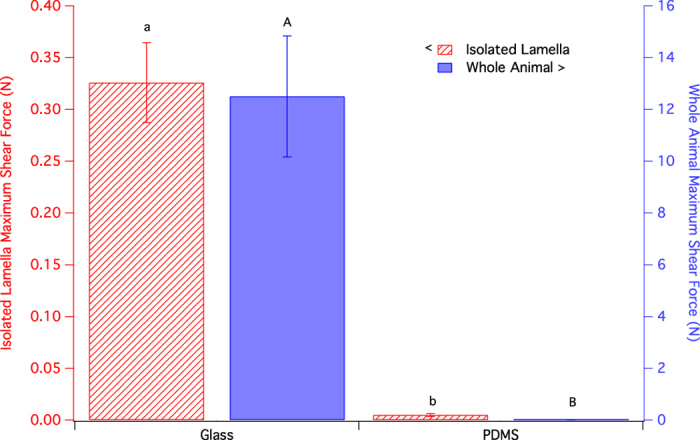
Average maximum shear force of adhesion for whole animal and isolated lamella on glass and 1000 μm PDMS substrates.Values are means ± standard error, n = 7 for both data sets. Results of student’s t-test are labeled in lower case for the isolated lamella experiments, and in upper case for the whole animal experiments.